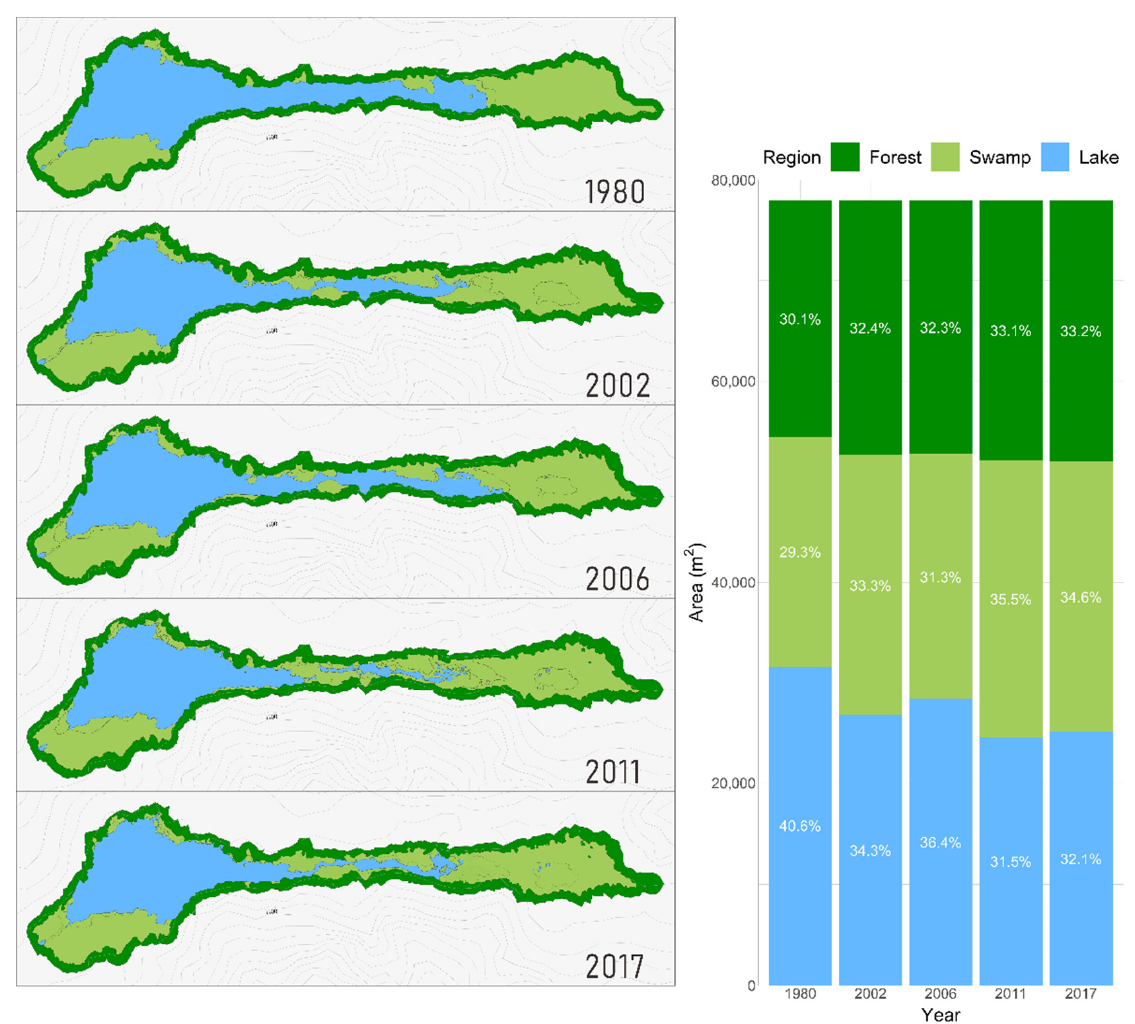
Figure 8. Change of lake and swamp area at the YYL site between 1980 and 2017. The forest area delineated in the figures was designated as a buffering zone of 10 m surrounding the lake/swamp areas for the aerial photo in 1980. As such, the total area of lake, swamp, and forest in the calculation was 77,931 m 2 . The percentage of each region was calculated on the basis of the total area.